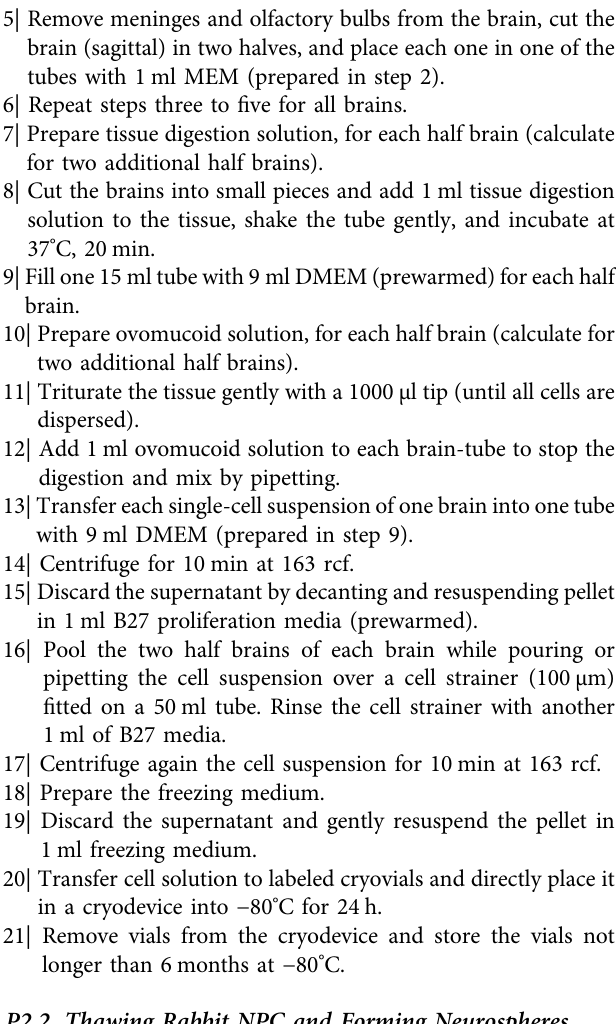
Protocol 2: Rabbit Neurosphere